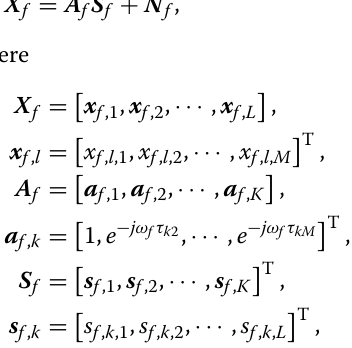
Frobenius norm are represented using (cid:2) · (cid:2) p and (cid:2) · (cid:2) F ,